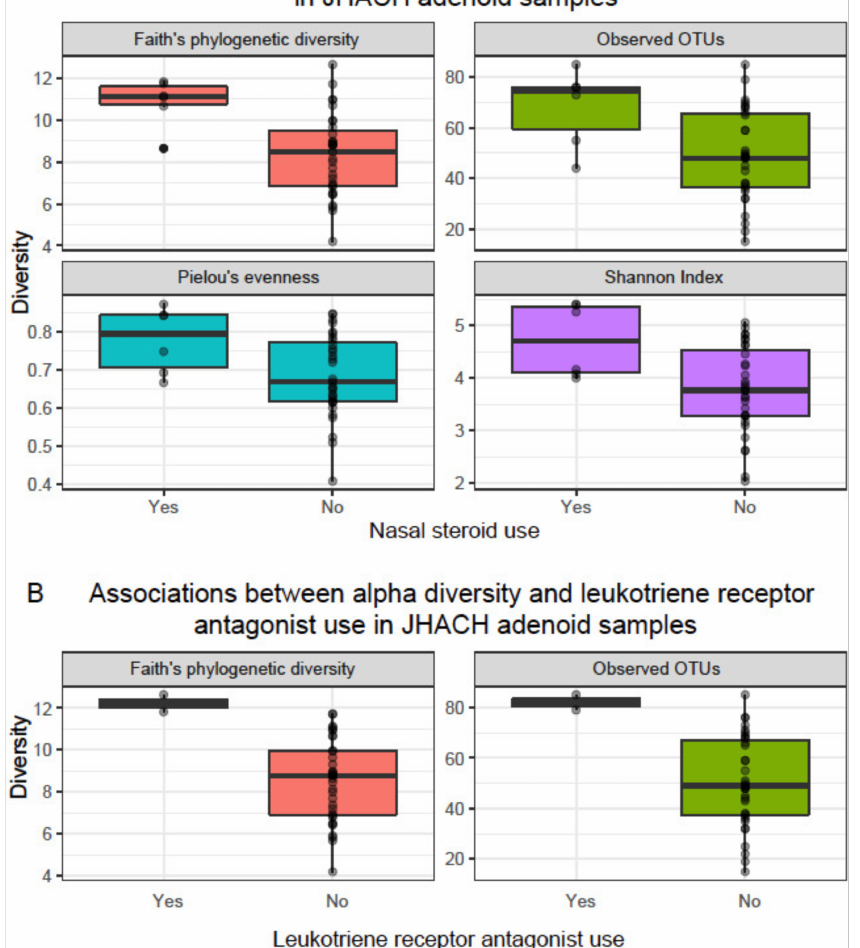
Figure 2. Statistically significant associations ( p < 0.05) between alpha diversity and ( A ) nasal steroid use; and ( B ) leukotriene receptor antagonist (LTRA) use in adenoid samples from patients undergoing adenoidectomy in the Johns Hopkins All Children’s Hospital (JHACH) cohort. Alpha diversity was computed using Faith’s phylogenetic diversity, observed operational taxonomic units (OTUs), Pielou’s evenness, and the Shannon